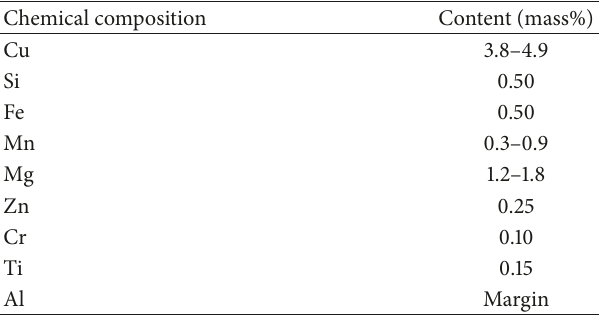
Table 1: Chemical composition in 2024-T31 aluminum-magnesium